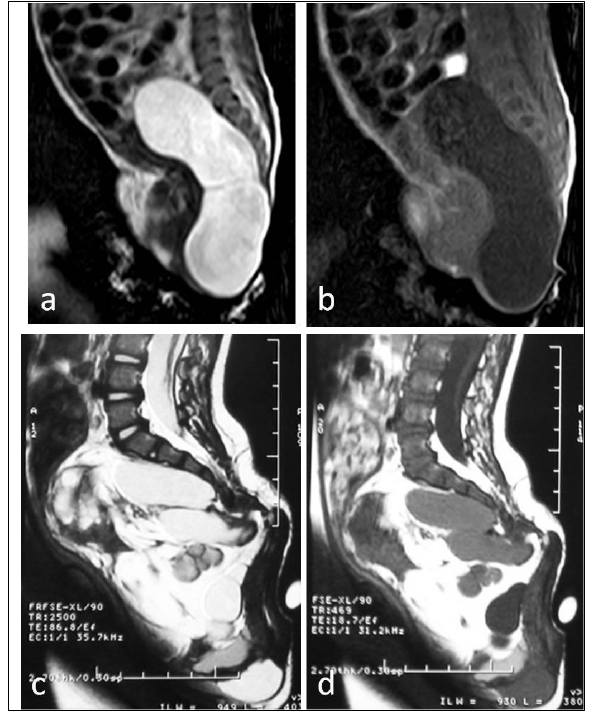
Figure 8: CT scan of a 3-year-old girl presenting with metasta- sizing malignant sacrococcygeal tumor. a) Predominantly solid sacrococcygeal mass. b) Tumor invasion of bony sacrum. c) Ab- dominal cuts showing liver metastasis. d) CT chest showing pulmonary